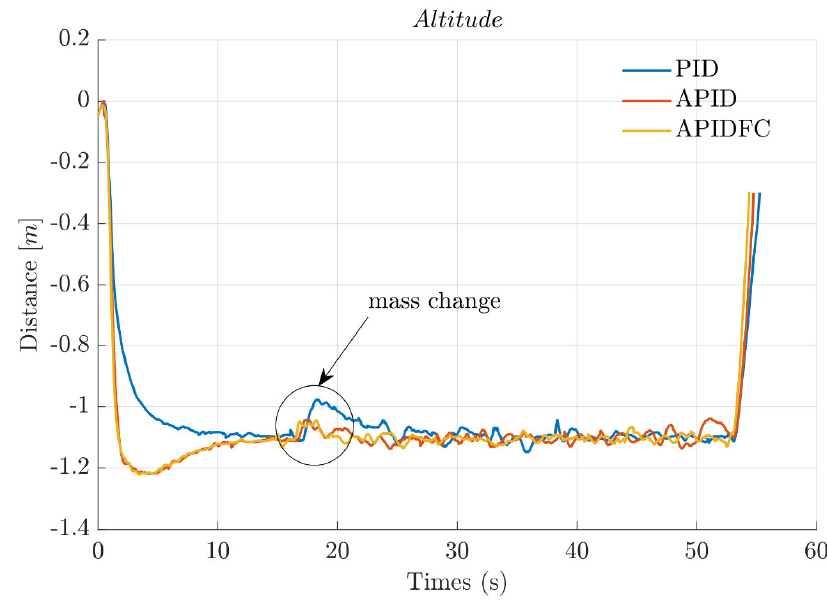
Figure 20. Altitude response comparison from the experiment.